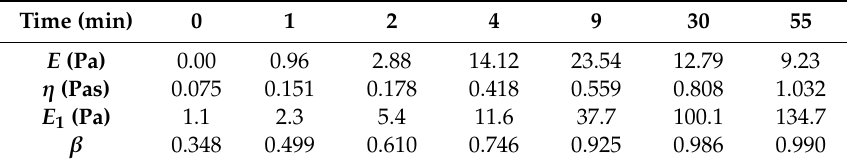
- - - - - - - - , 72 ° C , , 72 ° C , , 72 ° C , , 72 ° C ,